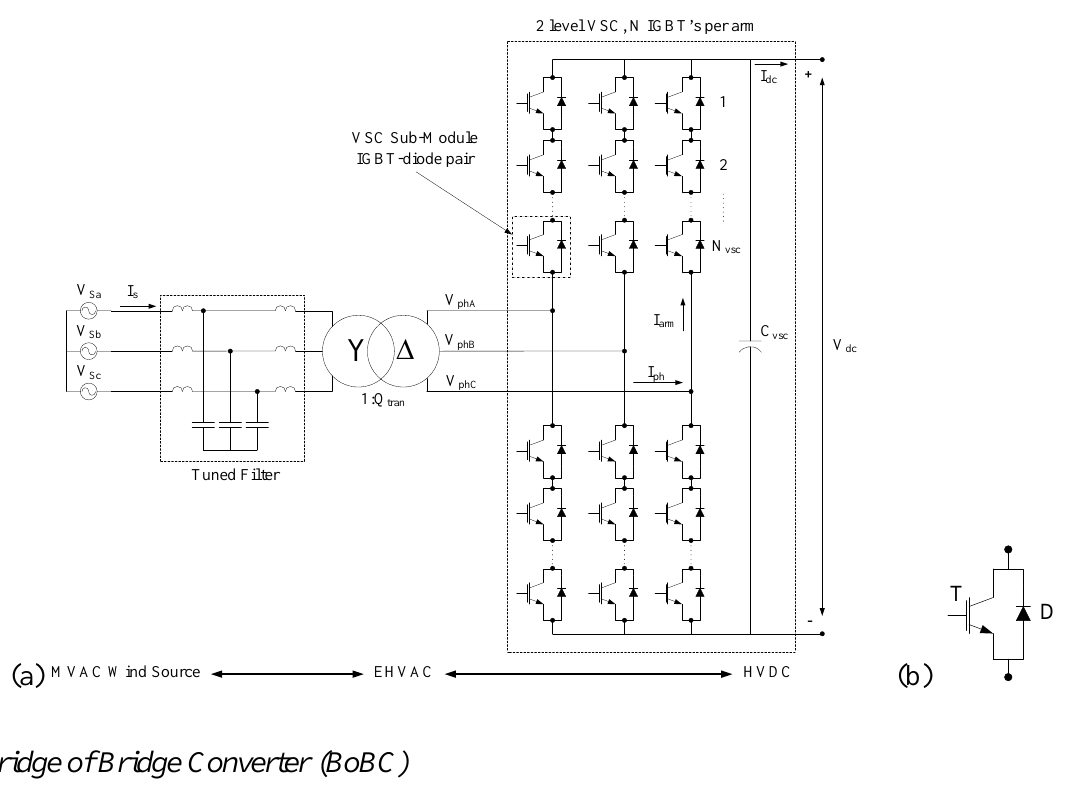
Figure 3. (a) Simplified schematic of a 2-level voltage sourced converter HVDC implementation, (b) IGBT-diode